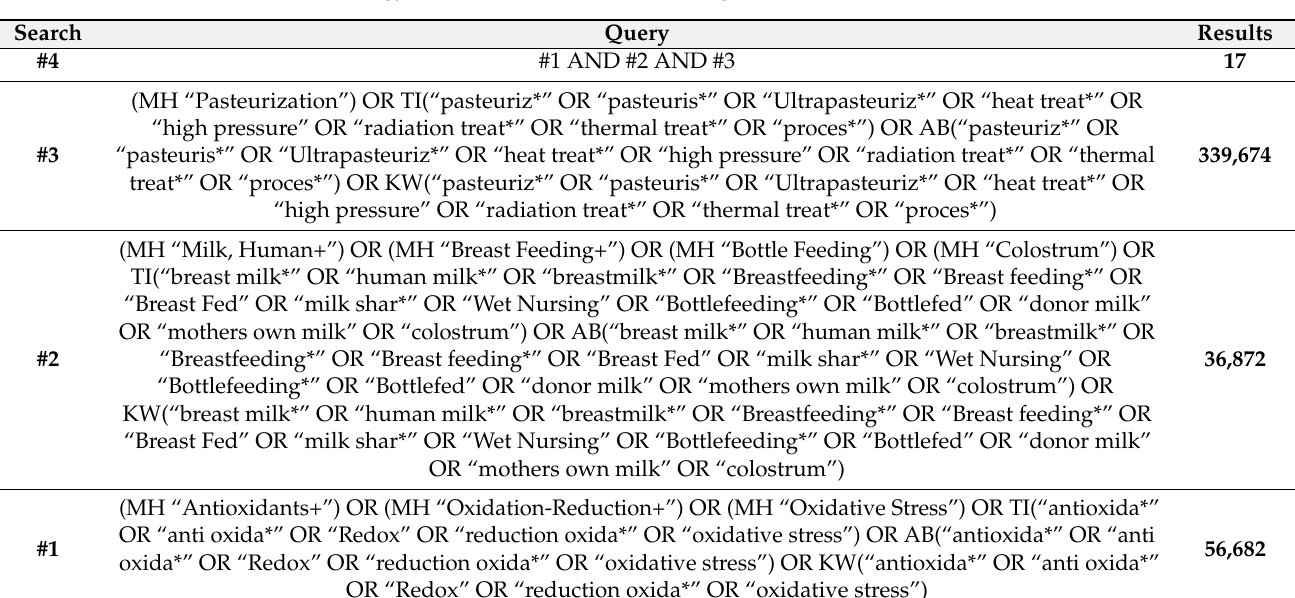
Table A3. Search strategy in Cumulative Index to Nursing and Allied Health Literature